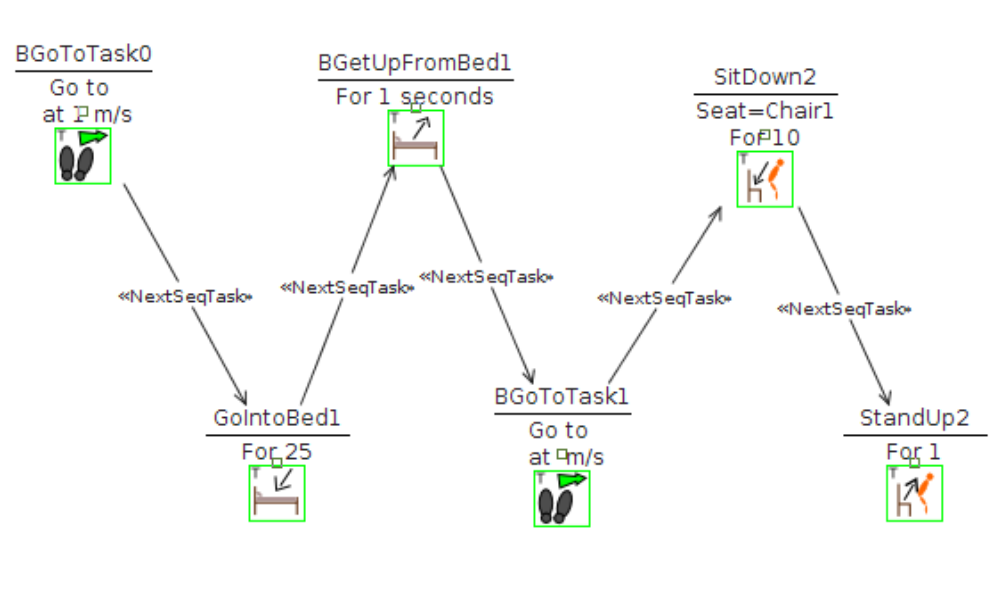
Figure 3. Sequence of moves the agent performs.